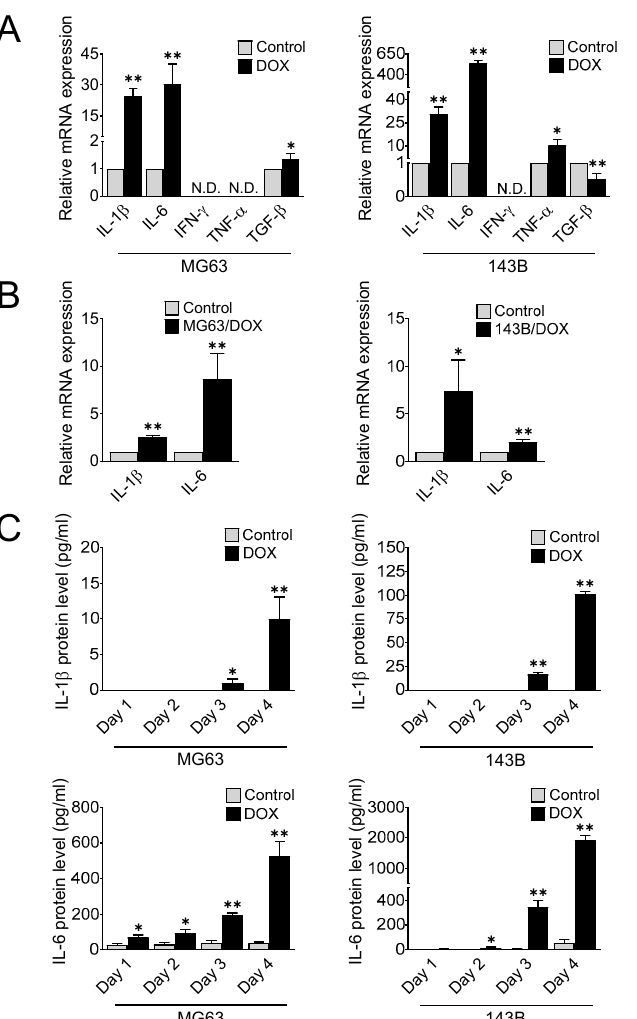
Figure 3. Doxorubicin enhances the expression of proinflammatory cytokines IL-1 β and IL-6 in osteosarcoma. ( A ) Gene expression of the proinflammatory cytokines IL-1 β , IL-6, IFN- γ , TNF- α , and TGF- β after doxorubicin treatment. Human osteosarcoma cells were treated with doxorubicin (40 nM) for 4 days, and qRT-PCR was performed to determine cytokine gene expression (N.D., not detected). The data represent the means ± SD. *, p < 0.05 and **, p < 0.01 vs. control (0.04% DMSO). ( B ) IL-1 β and IL-6 gene expression in MG63 and 143B cells after doxorubicin withdrawal for 10 days. The data represent the means ± SD. *, p < 0.05 and **, p < 0.01 vs. untreated parental cells. ( C ) Secretion of IL-1 β and IL-6 after doxorubicin treatment. Osteosarcoma cells were treated with doxorubicin (40 nM), and the culture media were collected on days 1, 2, 3, and 4 to determine the IL-1 β and IL-6 levels using ELISA. The data represent the means ± SD. *, p < 0.05 and **, p < 0.01 vs. control (0.04% DMSO).